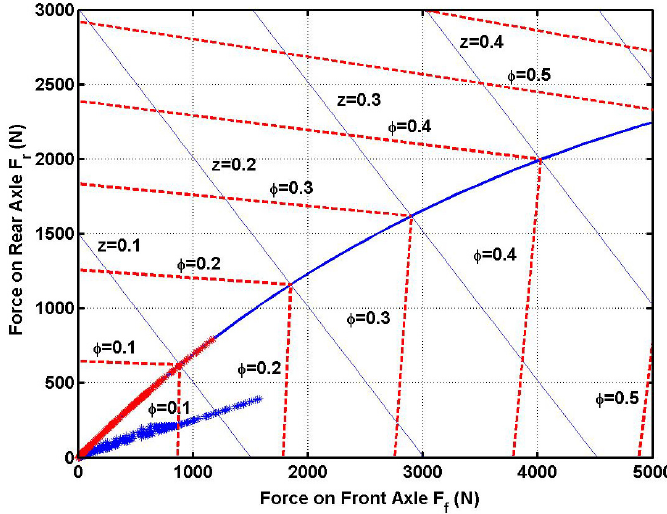
Figure 15. Braking force distribution between front and rear wheels.